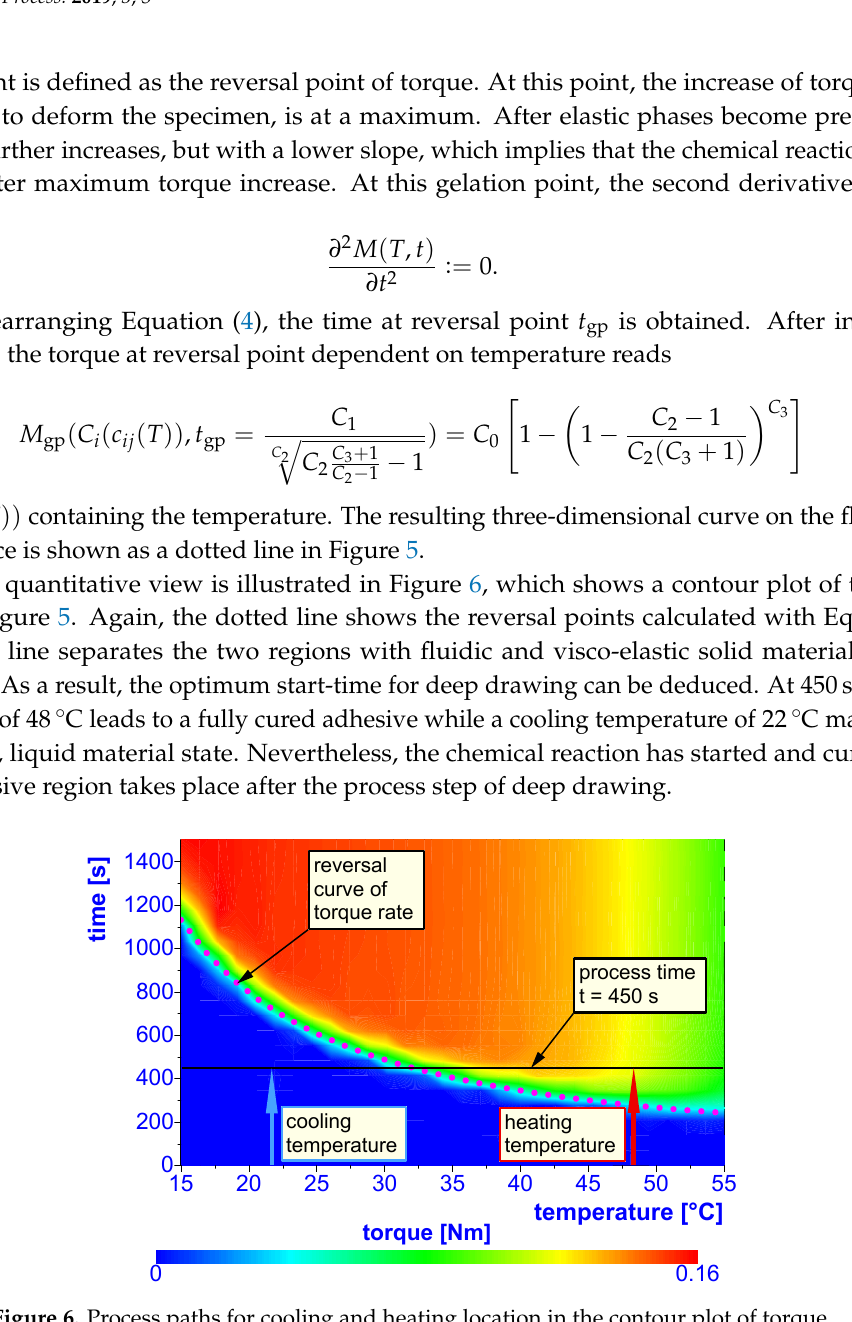
Figure 6. Process paths for cooling and heating location in the contour plot of